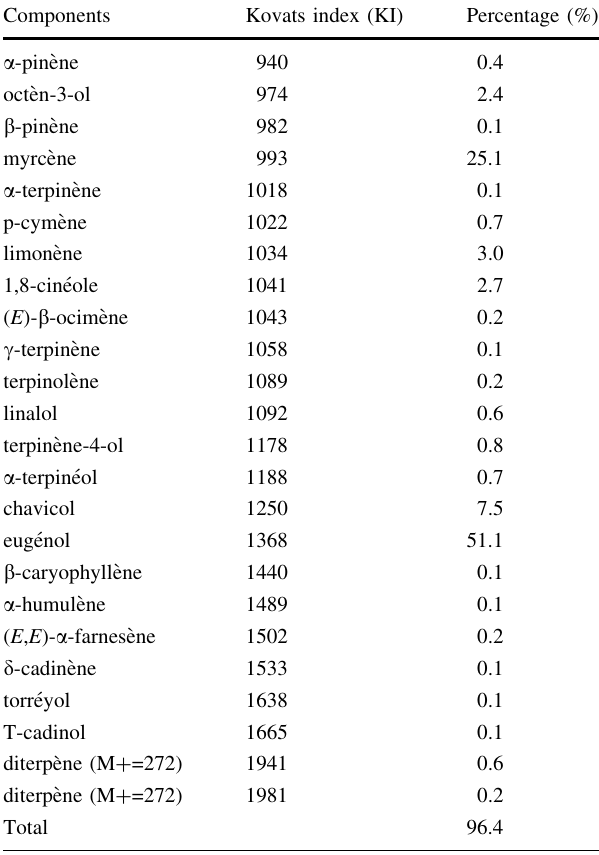
Table 1 Chemical composition of essential oil of Pimenta racemosa investigated